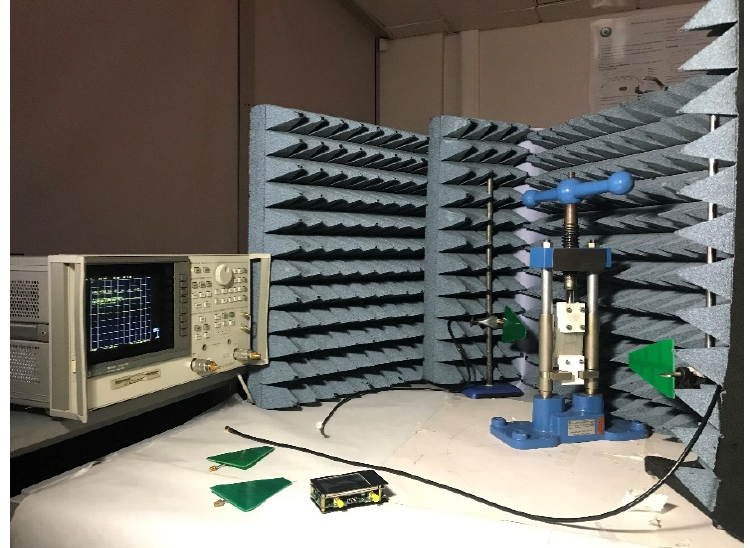
Figure 7. Opened test